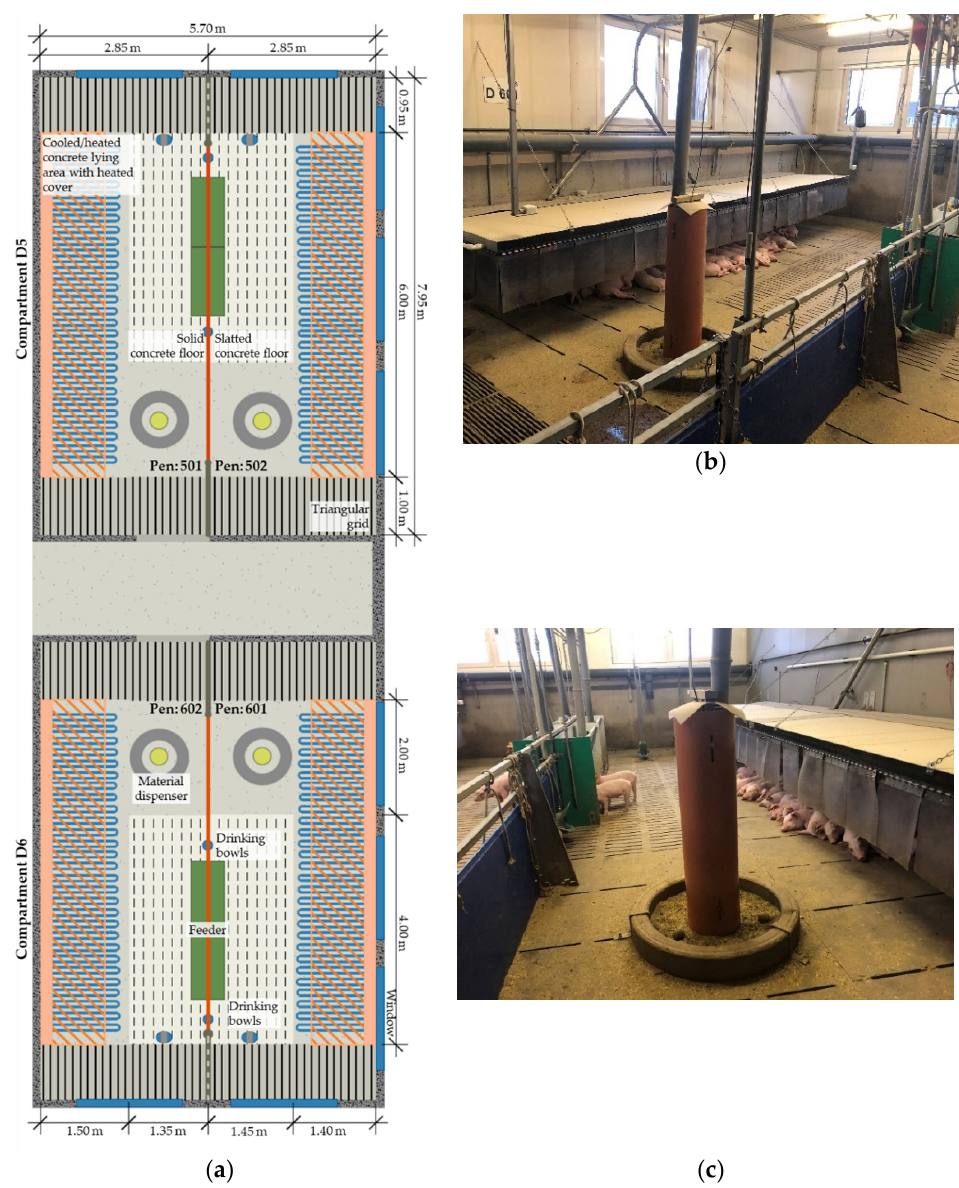
Figure 1. Plan of the two rearing compartments ( a ) photo of pen D601 and ( b ) pen D602 ( c ) with the employment material dispensers in the